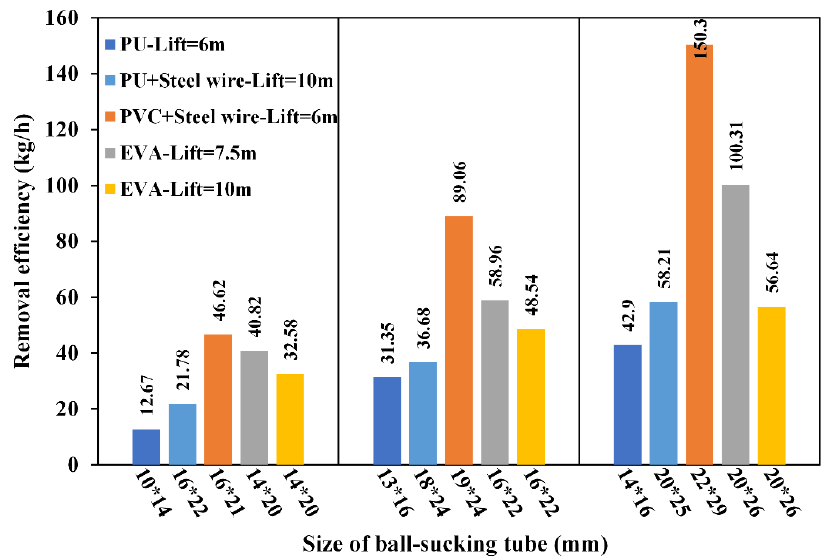
Figure 15. Removal efficiency of absorber balls in the gas environment.